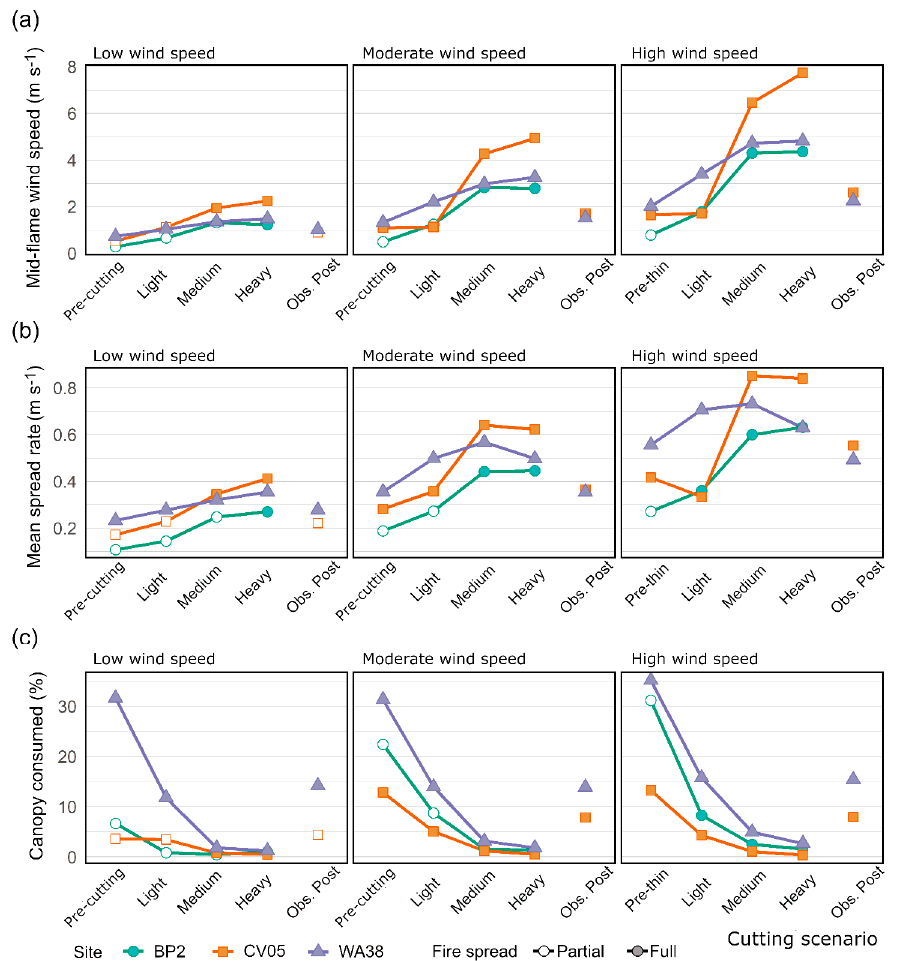
Figure 4. ( a ) Mid-flame wind speed, ( b ) mean rate of spread, and ( c ) percent of canopy consumed by site and open wind speed across five cutting scenarios; hollow and filled points indicate fires partially or fully spread across the study area, respectively.